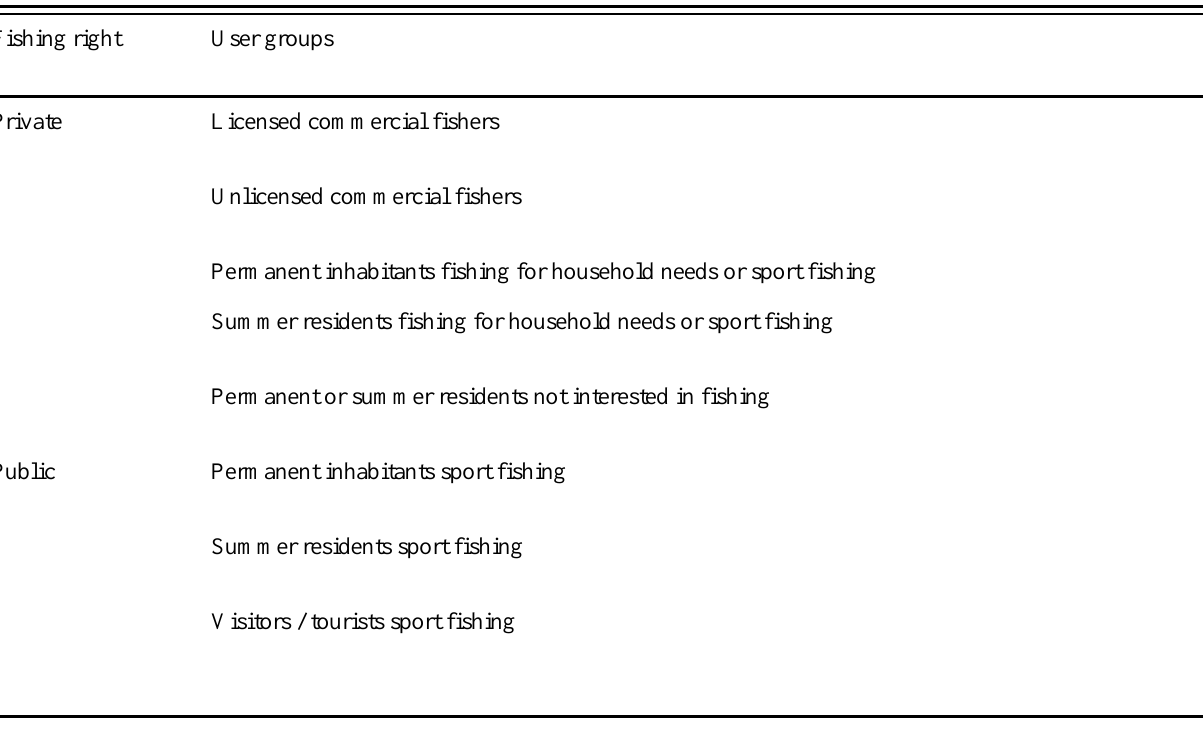
Table 3. User groups with different fishing rights identified in Ornö and Möja. Two main groups are fishers with private fishing rights (leaseholder or owner of individual or common waters) and fishers with public fishing rights. These can be further differentiated into permanent residents, summer residents, or visitors using commercial, household, or sport fishing methods (cf Sandström et al.